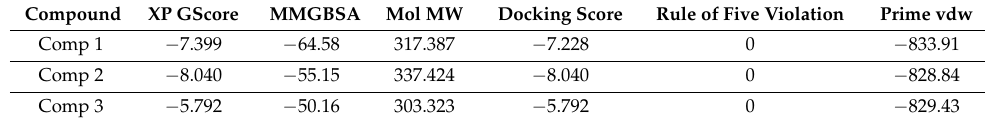
Table 1. Top 3 hits with their Glide score and MMGBSA values.